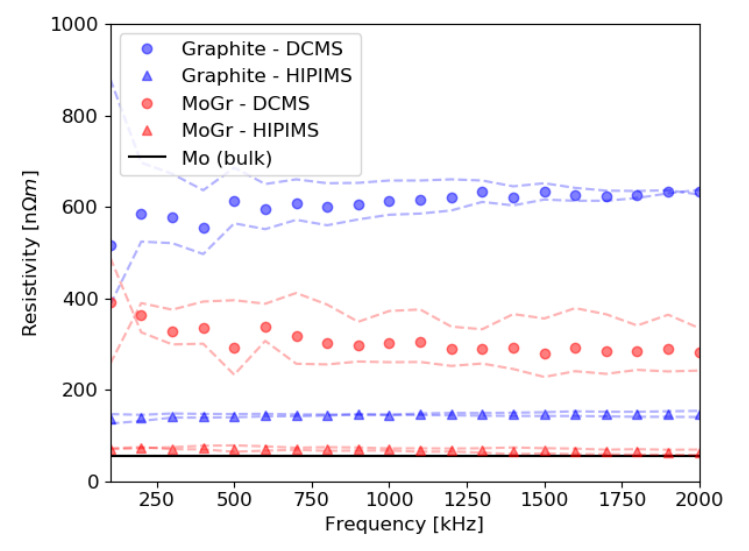
Figure 18. ECT measurement of Mo resistivity on graphite and MoGr for DCMS and